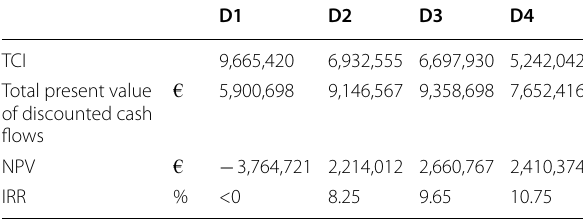
Table 10 Total present value for an interest rate of 2%, NPV after 10 years and IRR of the four downstream D1, D2, D3, and